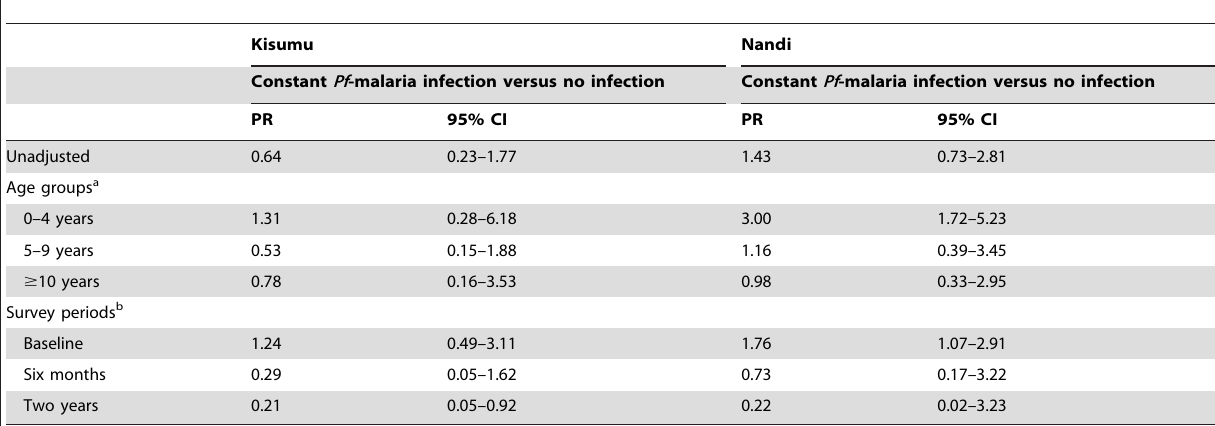
Table 3. Prevalence Ratios for EBV Lytic Antigen CD8 + T-cell IFN- c